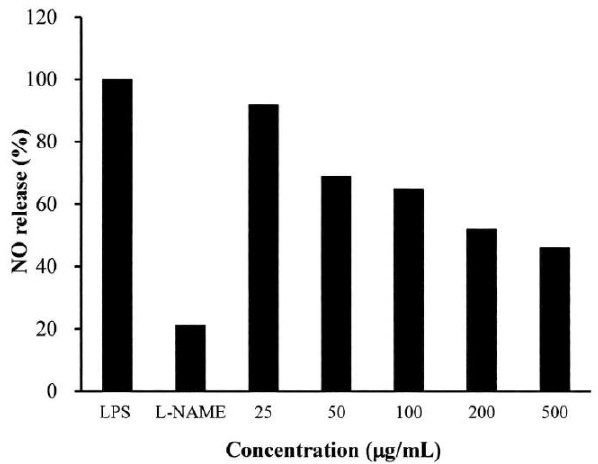
Figure 3. Nitric oxide (NO) release from the lipopolysaccharide (LPS)-treated RAW 264.7 cells decreased when the cells were pretreated with S. mukorossi seed oil. Data are from four independent experiments. The mean value of each group was normalized with LPS-only sample.